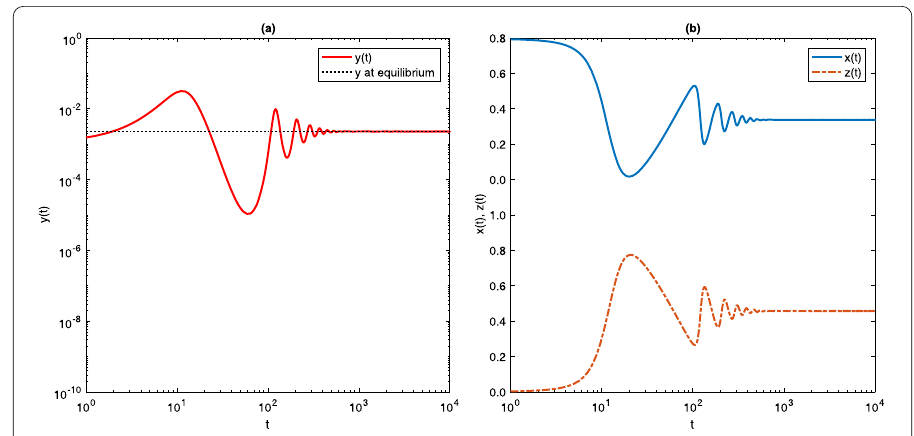
Figure 2 Time-dependent solutions for model (11) for R c = 1.3 and initial conditions x (0) = 0.999, y (0) = 0.001 and z (0) = 0.0. The prevalence of infection at equilibrium is ¯ y = 0.0023. Model parameter values are as shown in Table